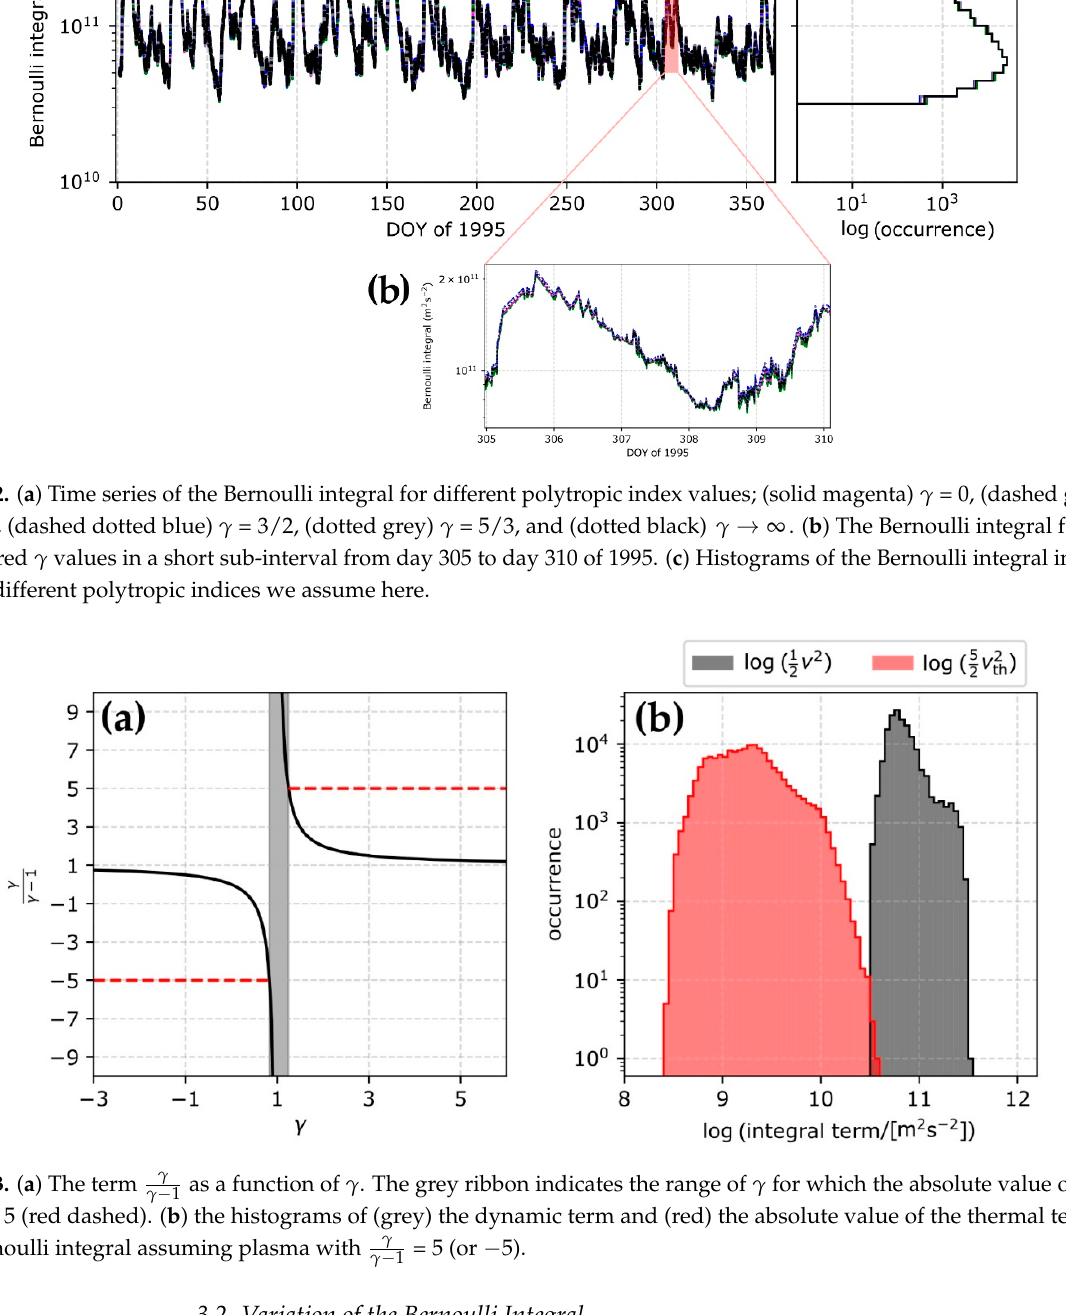
γ − 1 (cid:3082)(cid:2879)(cid:2869)